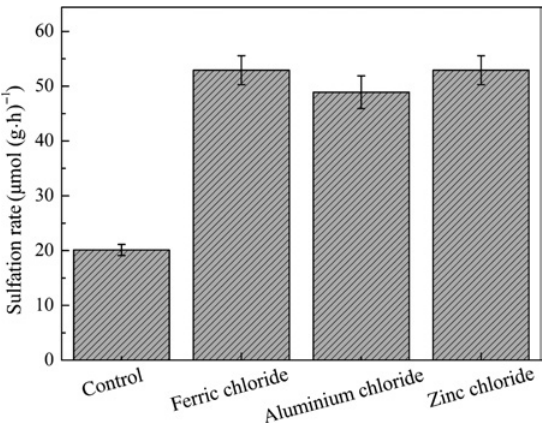
Figure 1: Effects of the sulfation reaction kinetics of Sorghum vinegar residue (SVR) and sulfuric acid, initiated by Lewis acidic salts for ferric chloride, aluminum chloride and zinc chloride, respectively. A feedstock ratio of 1.0 mmol/g SVR, and a radical ini- tiator amount of 1.0% were used. The reaction was carried out under wet curing at 180 °